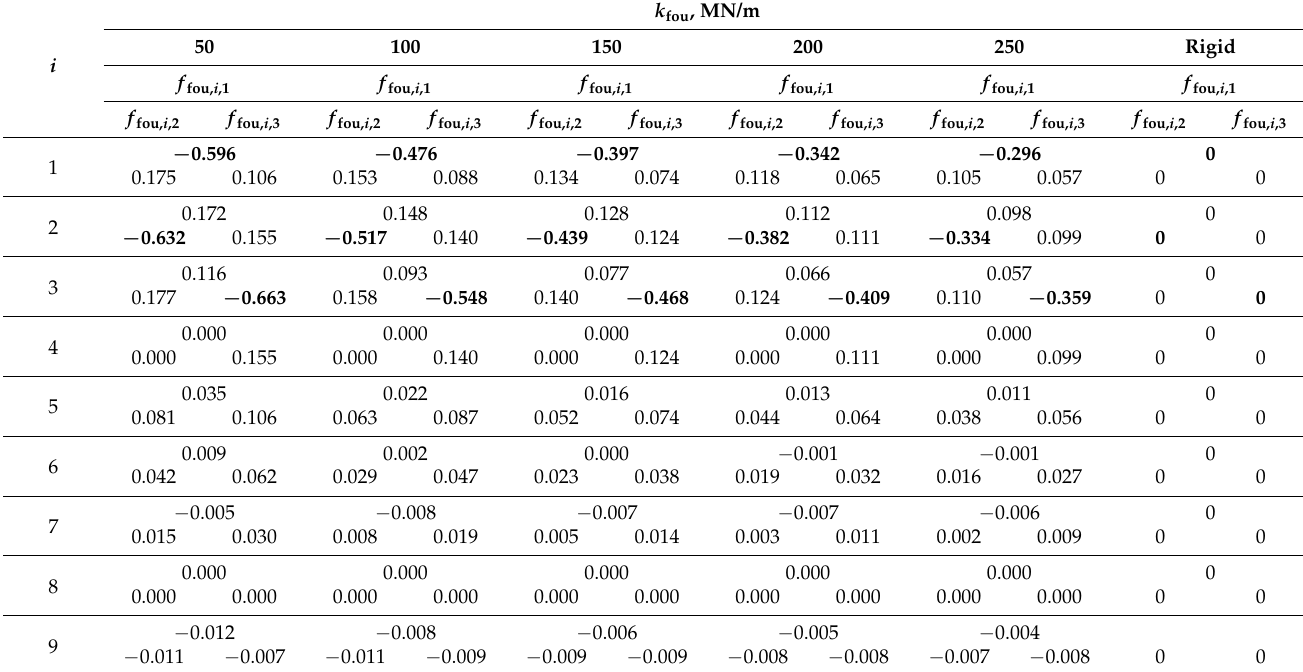
Table A13. Values f fou, i , j , [-] of the matrix f fou of support displacement forms for n = 32, k fou = 50, 100, 150, 200, 250 MN/m and k fou - rigid (elements f fou, j,j ( i = j ) are given in